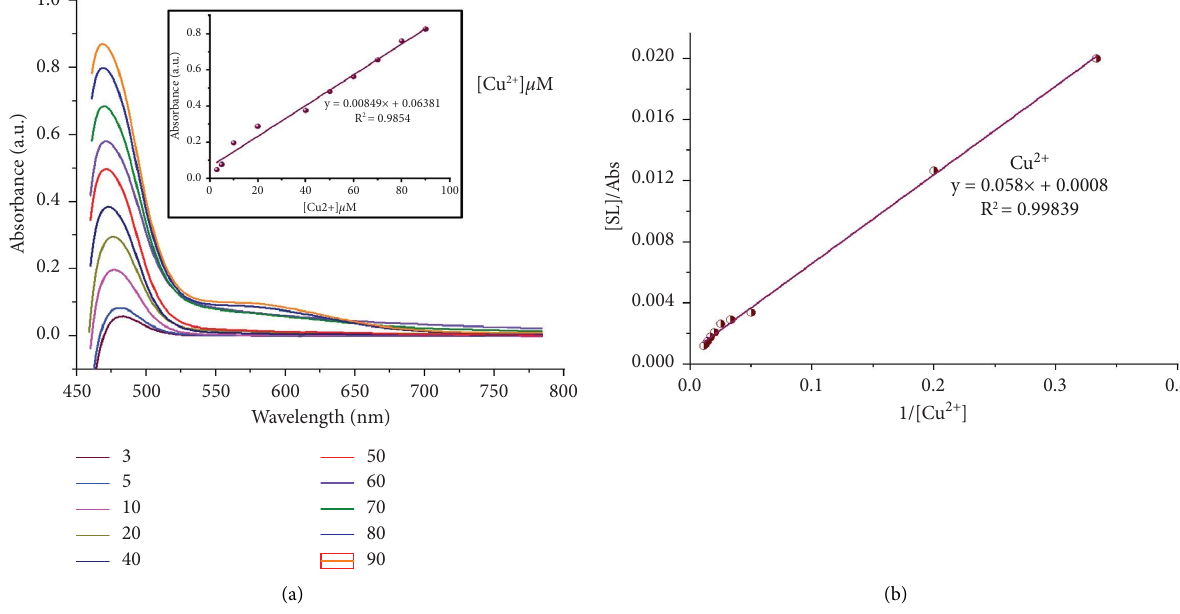
Figure 4: (a) UV–visible absorption spectra of SL upon the addition of diferent equiv. of Cu 2+ ions with absorbance intensity of SL as a function of Cu 2+ concentration at 470nm (inset), and (b) Benesi–Hildebrand plot of [SL]/Abs against 1/[Cu 2+ ].